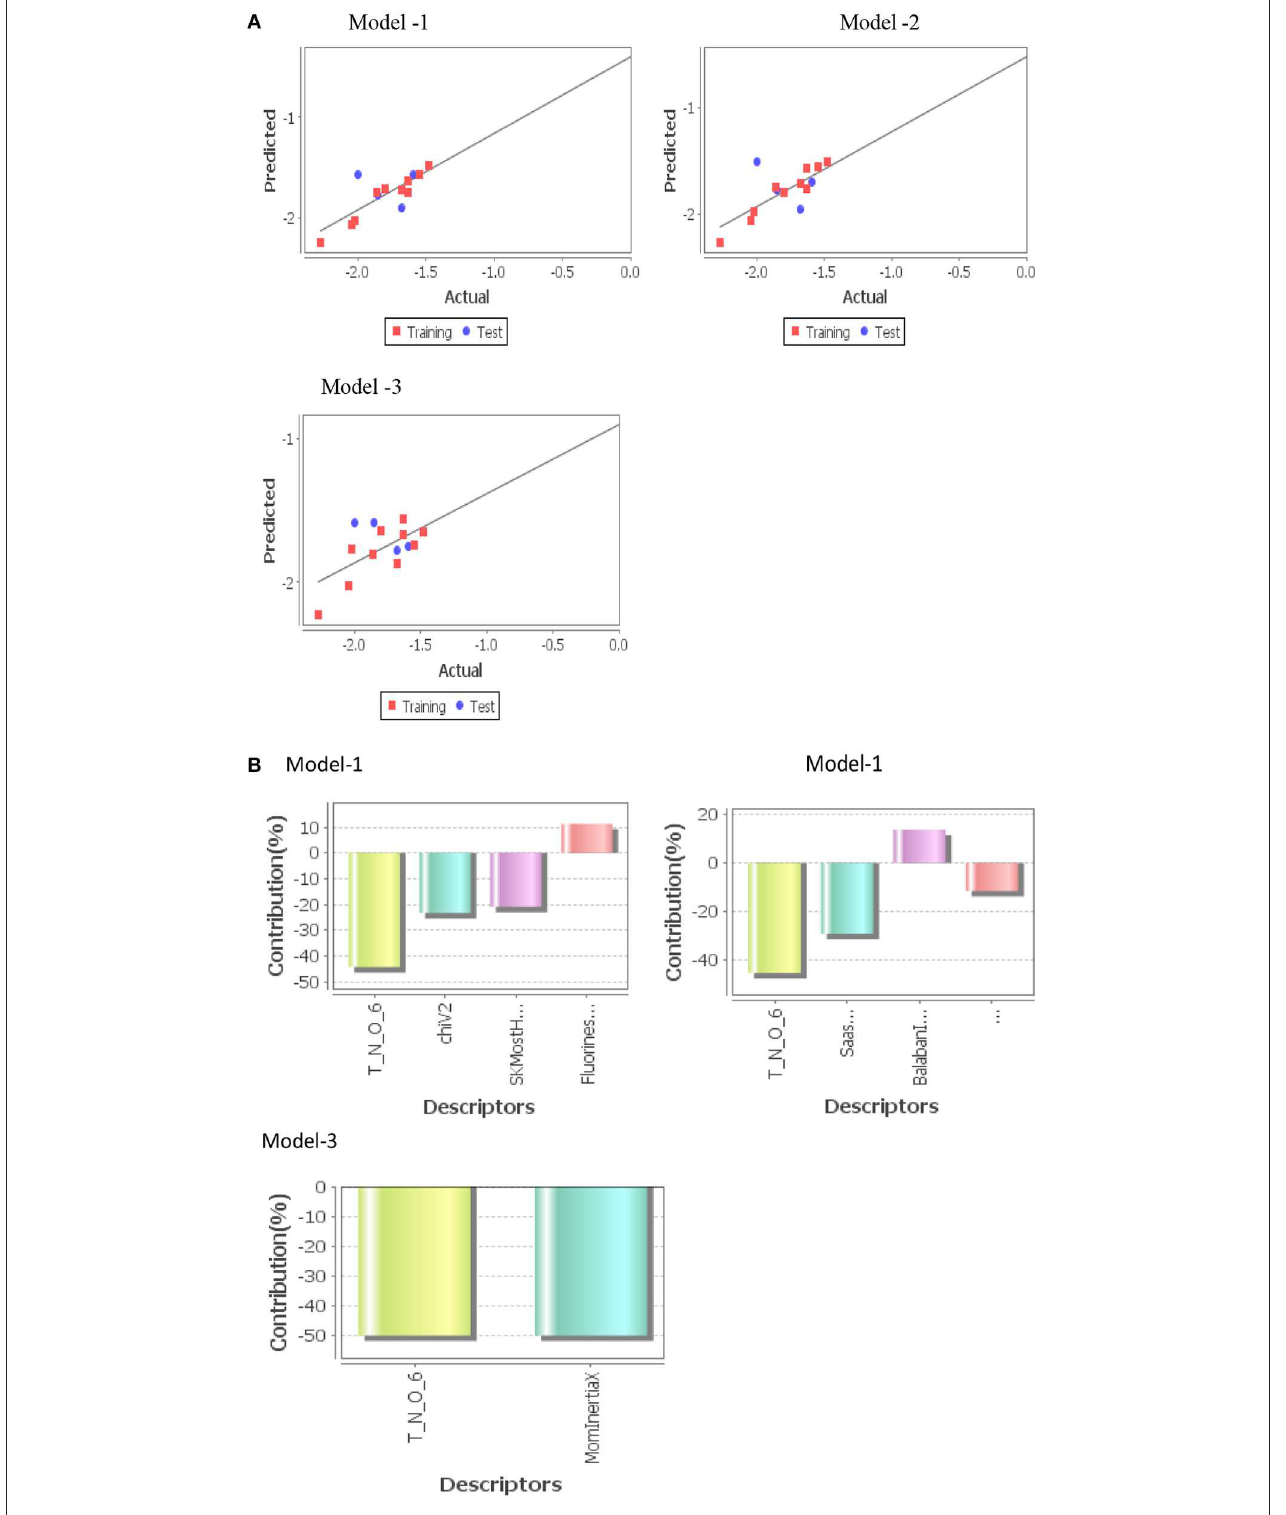
FIGURE 5 | (A) Graphs of experimental vs. predicted fungicidal activity of different models against A. solani. (B) Contribution charts of 2D-QSAR models.